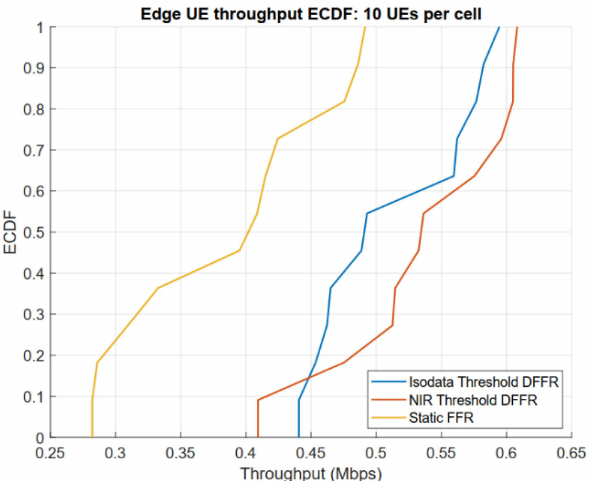
Figure 7. Edge UE throughput ECDF for 10 UEs per